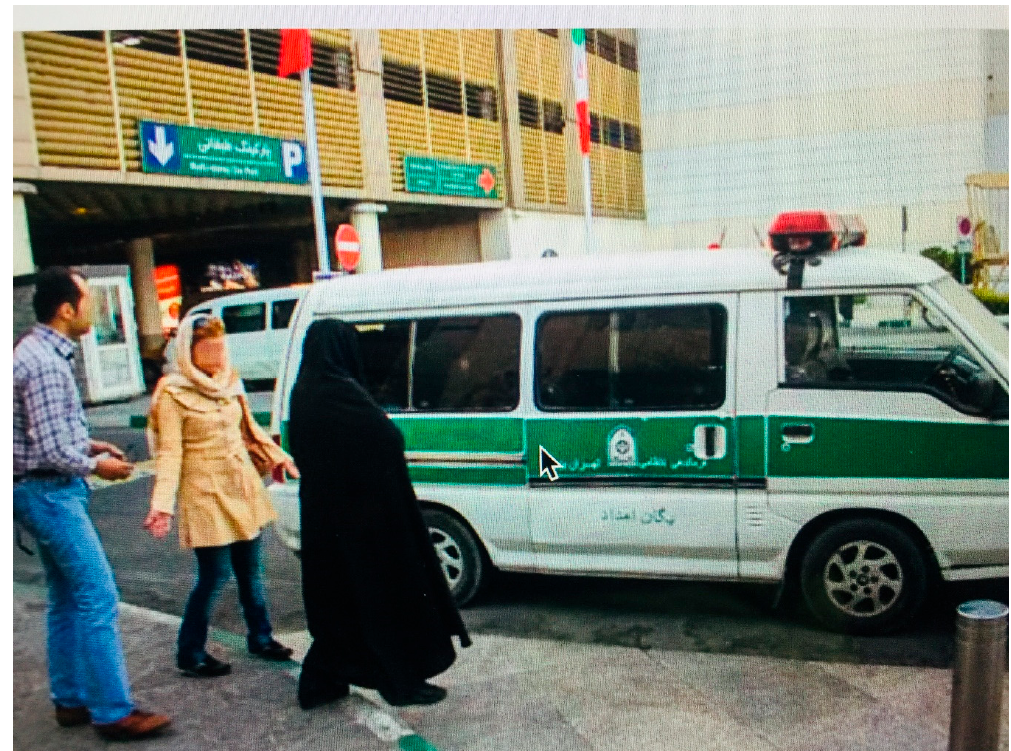
(cid:88)(cid:65) (cid:17) (cid:131)(cid:80)(cid:64) (cid:16) (cid:73) (cid:17) (cid:130)(cid:195) ) the morality police is arresting a